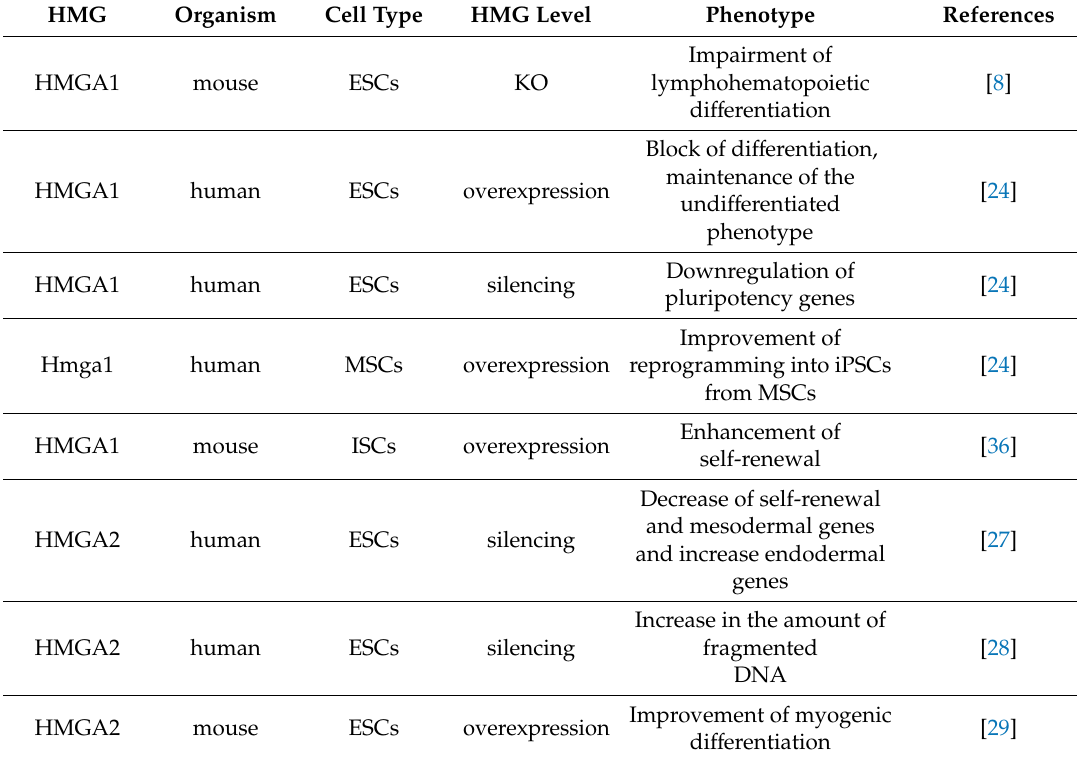
Phenotype resulting from alteration of HMGA expression in stem cells and in